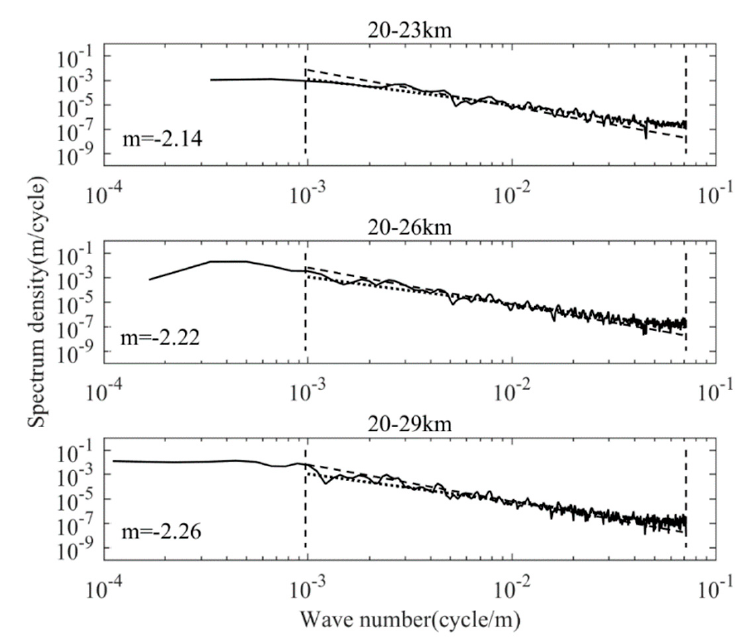
Figure 3. Vertical wavenumber spectra of normalized temperature fluctuations observed at intervals of 20–26 km (top panel), 20–32 km (mid panel), and 20–38 km (bottom panel). The dashed line indicates the saturated spectrum amplitude predicted by Equation (8); the dotted line indicates the spectrum amplitude of the best linear fit, and the corresponding slope is marked on the graph.